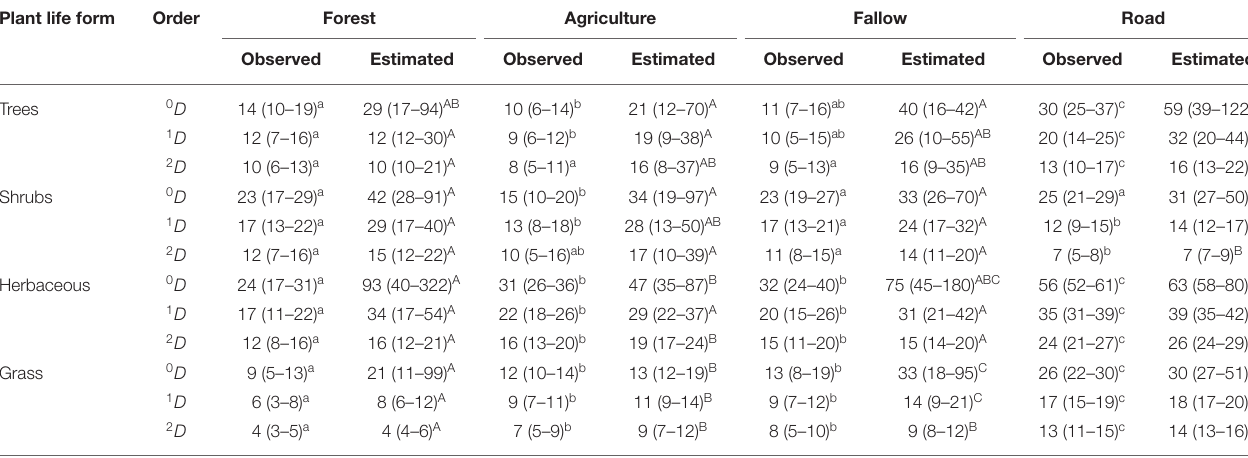
TABLE 2 | Comparison of sample-based interpolation [Observed (CI at 95%)] and extrapolation [Estimated (CI at 95%)] for species richness ( 0 D ), the effective number of species from Shannon ( 1 D ), and effective number from Simpson ( 2 D ), of roadside against land-uses for each plant life form in Moribane Forest Reserve, Mozambique. Plant life form Order Forest Agriculture Fallow Road Observed Estimated Observed Estimated Observed Estimated Observed Estimated Trees